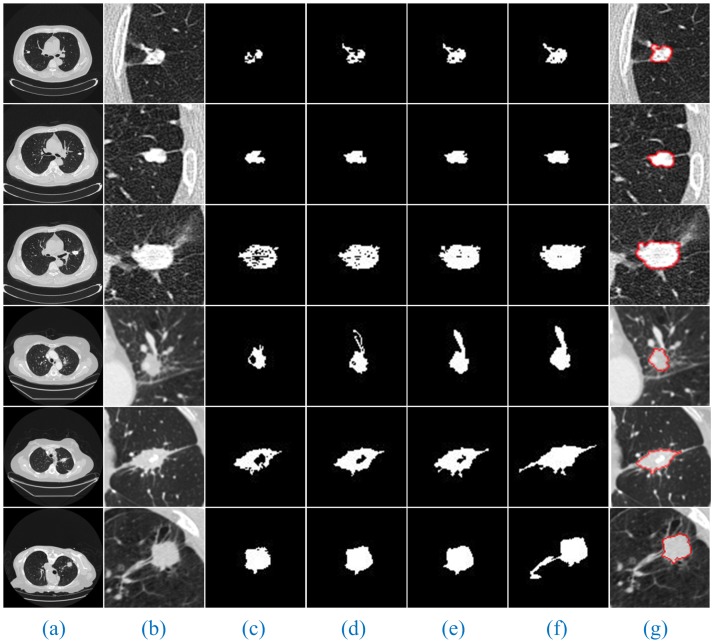
The segmentation results of RG for juxta-vascular nodules.The detailed descriptions are the same as presented in Fig 10.